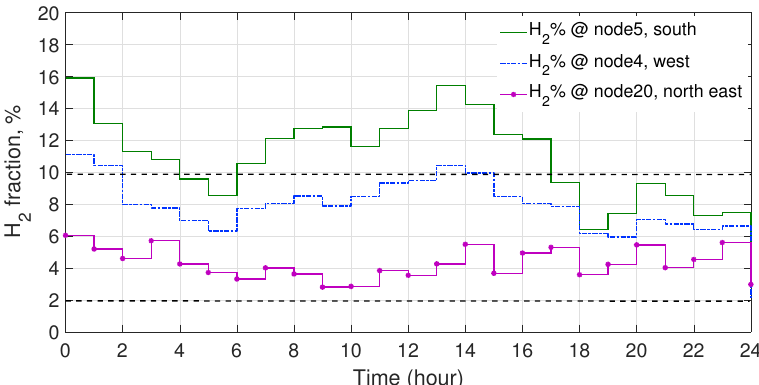
Figure 6. Hydrogen fraction % from different nodes (4, 5, 20) outputs. Table 2. H 2 concentration in different regions of Ireland during simulated 24 h.